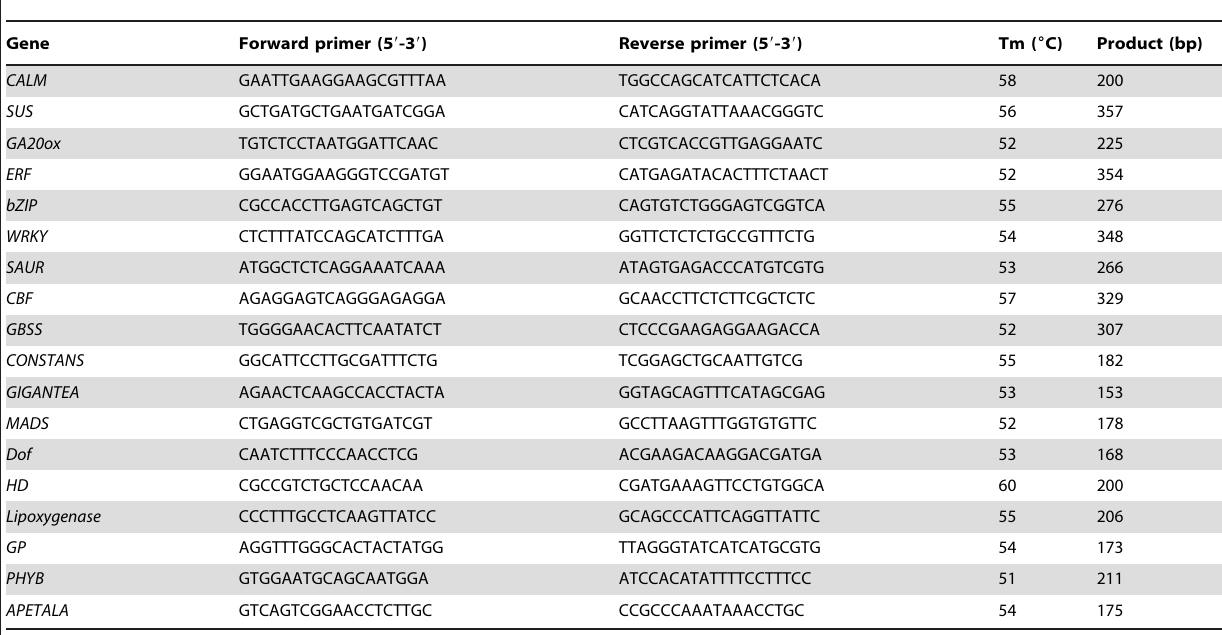
Table 1. Detailed information about primers used for qRT-PCR variation.